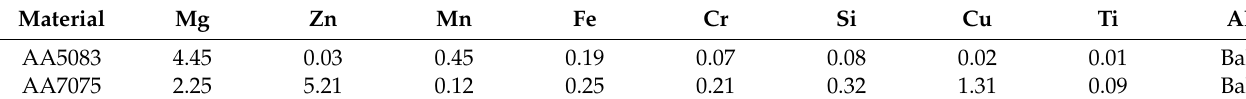
Table 1. Chemical compositions of AA5083 and AA7075 (wt. %).